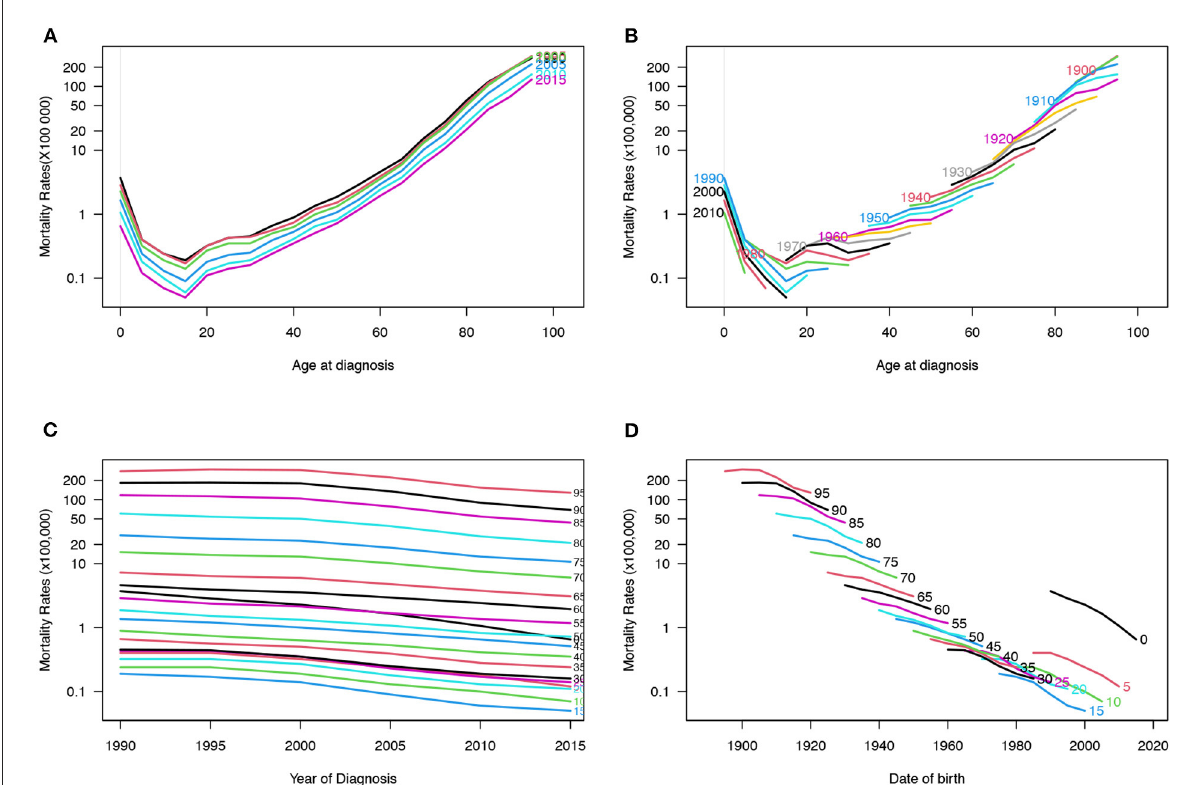
FIGURE6 Mortality rates of IBD in China. (A) The age-specific mortality rates of IBD according to time periods; each line connects the age-specific mortality for a 5-year period. (B) The age-specific mortality rates of IBD according to birth cohorts; each line connects the age-specific mortality for a 5-year cohort. (C) The period-specific mortality rates of IBD according to age group; each line connects the birth cohort-specific mortality for a 5-year age group. (D) The birth cohort-specific mortality rates of IBD according to age groups; each line connects the birth cohort-specific mortality for a 5-year age group.